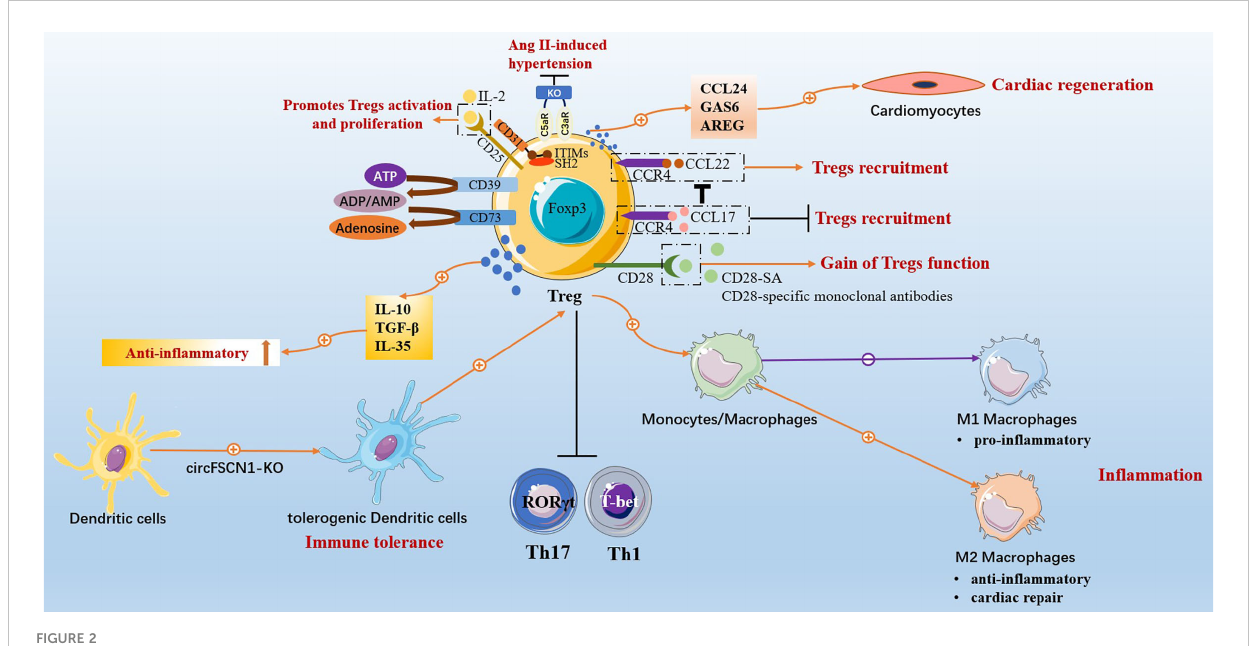
FIGURE 2 Protective effects of Conventional CD4 + CD25 + Foxp3 + Tregs in cardiovascular